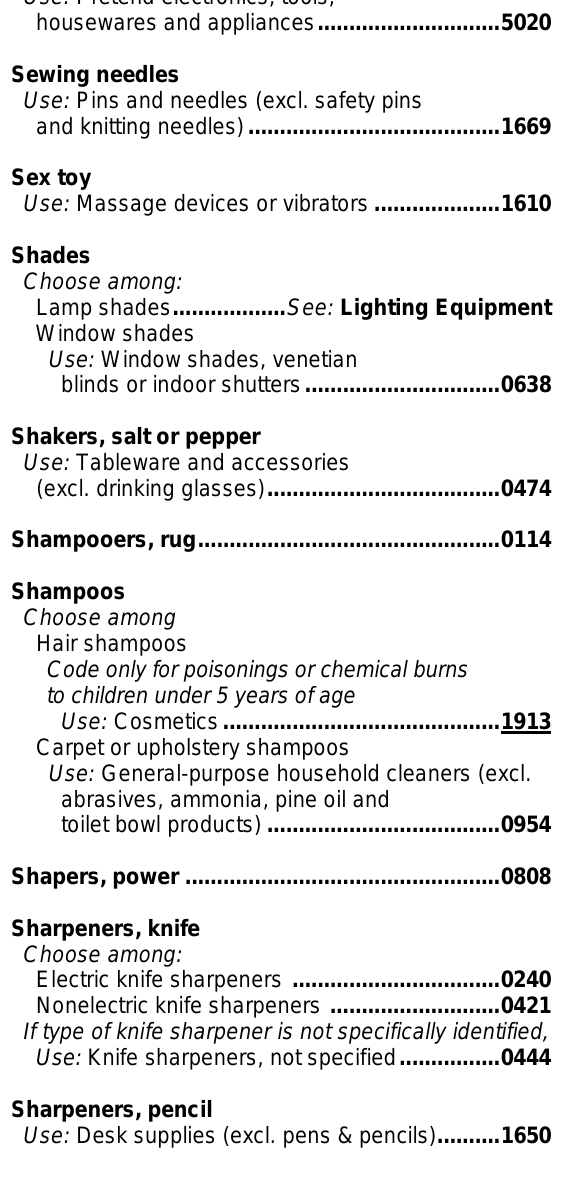
Sewing machines, toy Use: Pretend electronics, tools, Sewing needles Use: Pins and needles (excl. safety pins